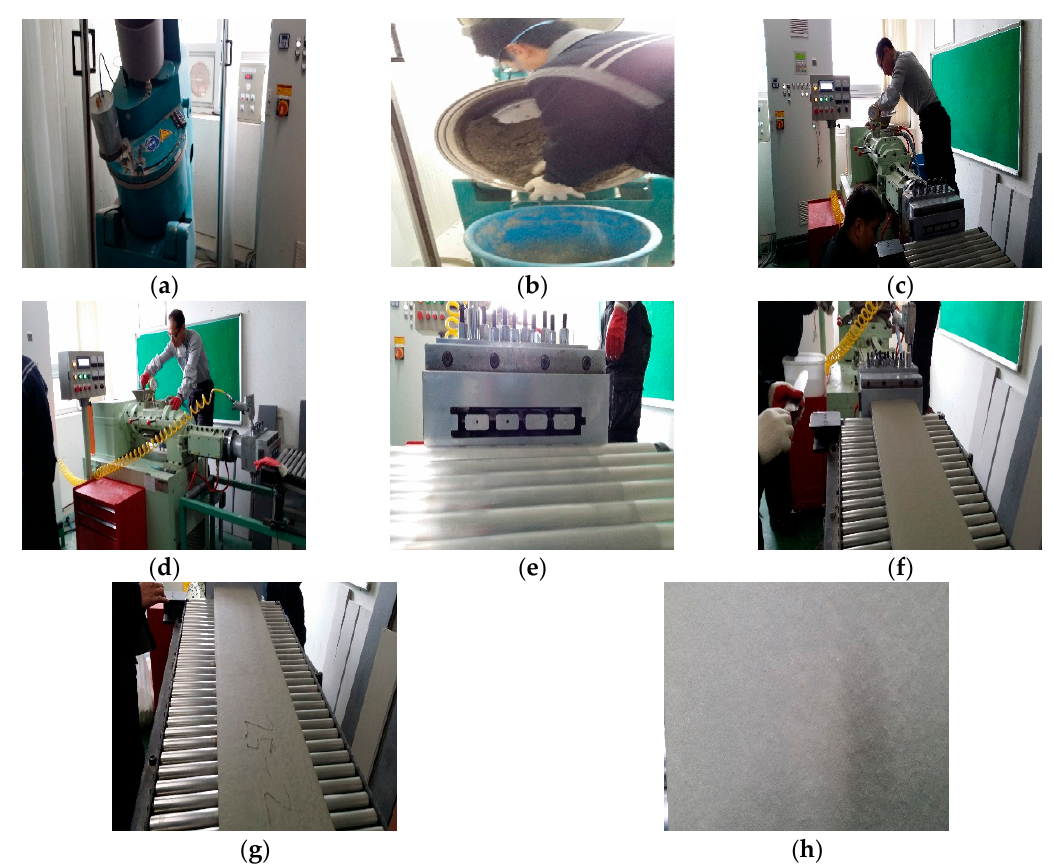
Figure 1. Production method of extrusion panel: ( a ) mixer; ( b ) mixing materials; ( c ) setting of extrusion machine; ( d ) input materials; ( e ) extrusion; ( f ) correction of horizontal; ( g ) manufacturing of panel; ( h ) surface of extrusion panel.